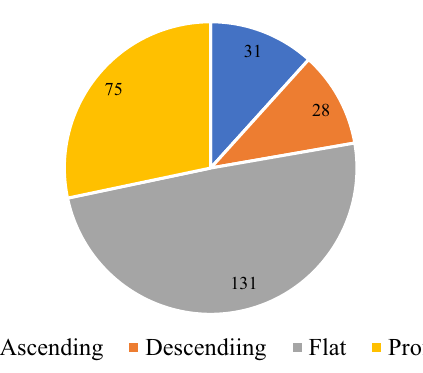
Figure 2. The numbers of affected ears in different hearing lever group.